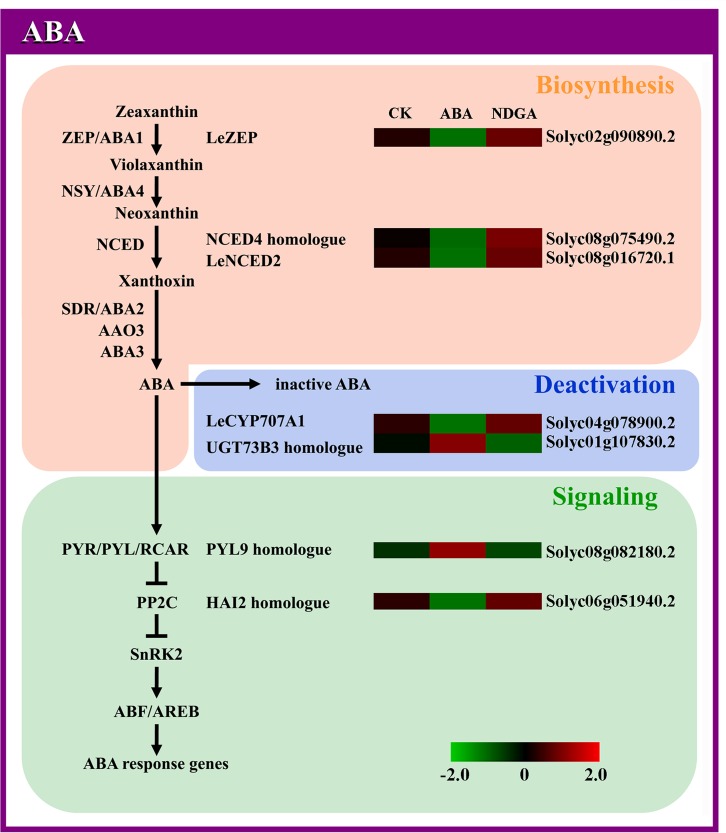
Analysis of DEGs involved in the pathway of ABA biosynthesis, deactivation and signaling.Abbreviations are listed in S10 Table, and other details are the same as in Fig 2.